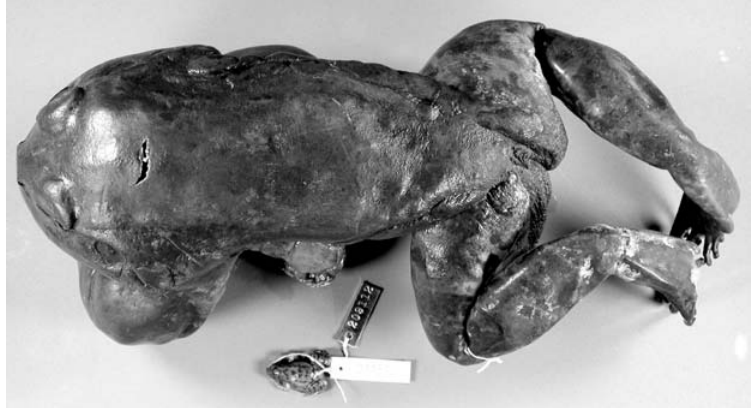
Fig. 1 – Smallest and largest individuals used to determine measurement error, showing both the size differences involved and variation in quality of preservation. Above – Leptodactylus vastus , USNM 109144; below – Adenomera marmorata , USNM